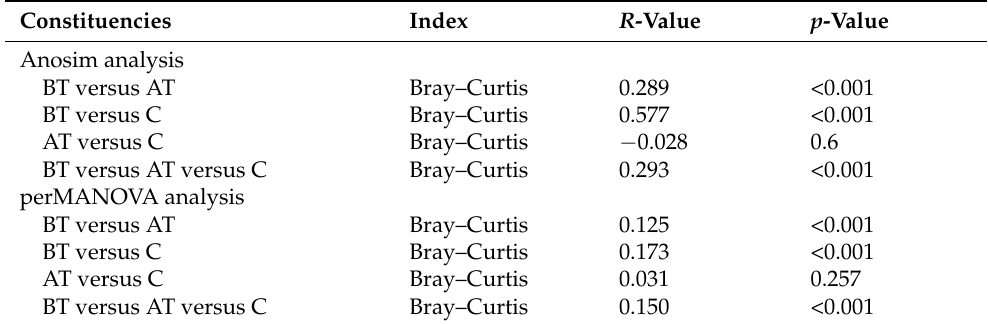
Table 2. Difference in microbial communities between the pre-treated (BT), treated (AT), and control (C) groups measured through Anosim and perMANOVA.